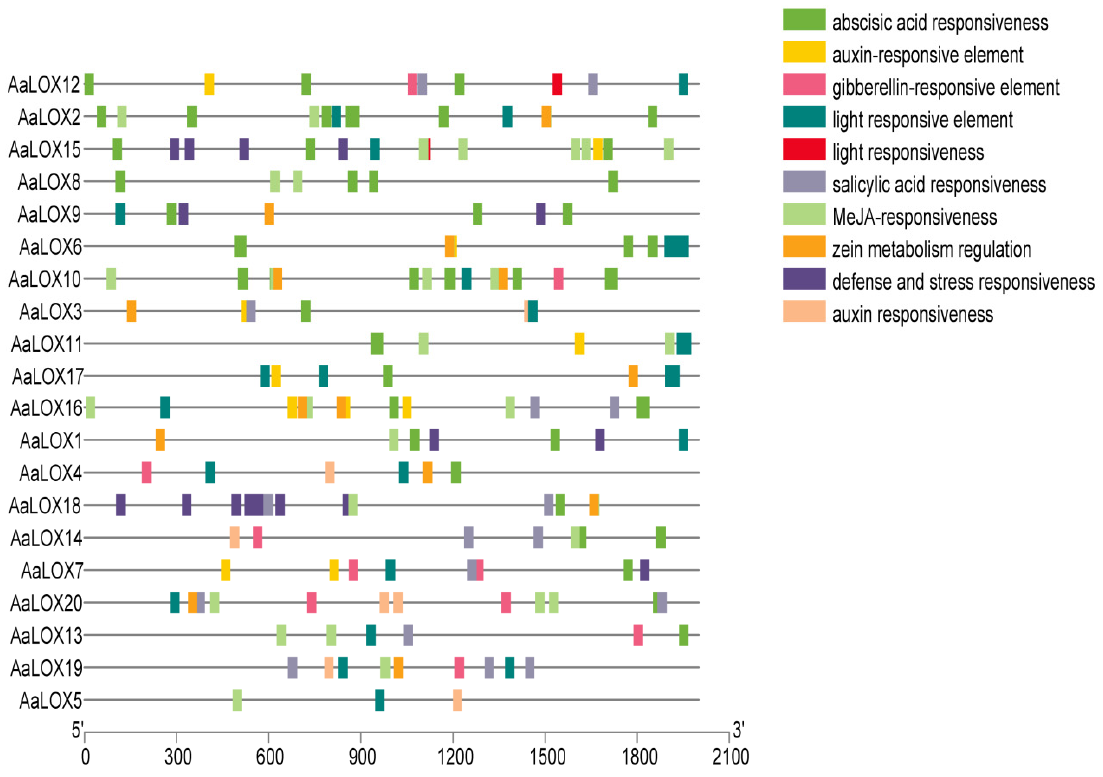
Figure 5. Prediction of cis-acting elements in the promoter of AaLOX gene family. The colored boxes on the right denote cis-acting elements and the same function are shown in the same color .